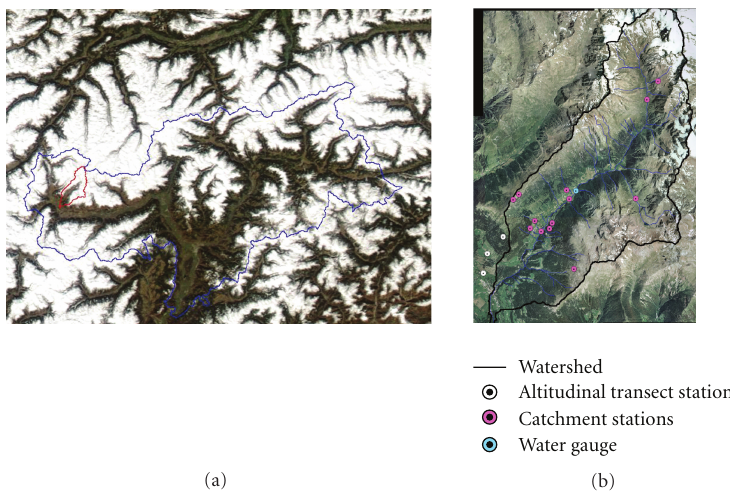
Figure 1: Study area of the SOFIA project: (a) Alto Adige Province and (b) Mazia Valley, with the localization of the fixed measurement stations. The stations called “Transect” are the most complete ones, including 4 soil water content sensors in each station at two depths (5 and 20cm). The stations called “Catchment” include one soil water content sensor at two depths (5 and